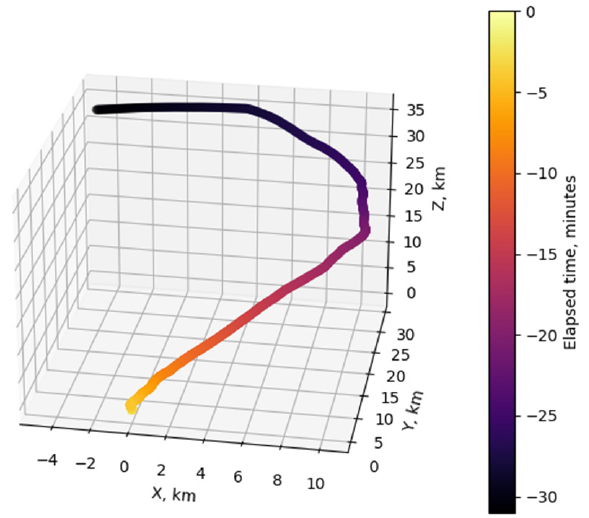
Figure 8. Bounder height chronology relative to the end of the record.